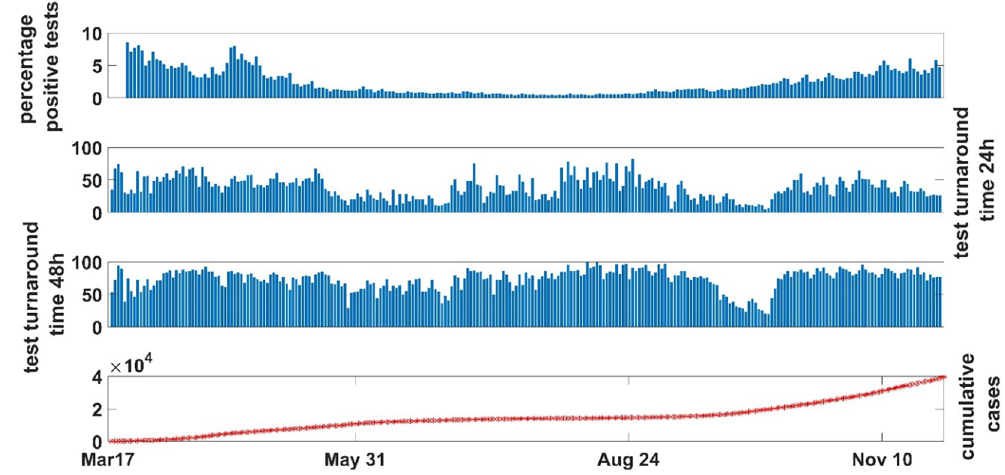
Fig 3. Percentage positive tests, tests turnaround times (24h-48h) and cumulative cases are reported from March 17, 2020 to November 28, 2020 in Toronto. The percentage positive tests decrease from May 31 to August 24, when it starts increasing, showing, however a magnitude smaller than the first wave in March. Until May 31 about 50% of the tests were returned within 24h, while until the end of August, the trend shows an initial decreasing followed by an increasing trend. After this, the curve decreases again, raising up in October and remaining below 50%. However, it slightly decreases again after November 10. Similar pattern for 48h tests turnaround time. The cumulative cases increase until May 31, and then remain stable until the end of August when the increase starts again and continue until Dec 2, 2020, with a slight decrease after the beginning of November.